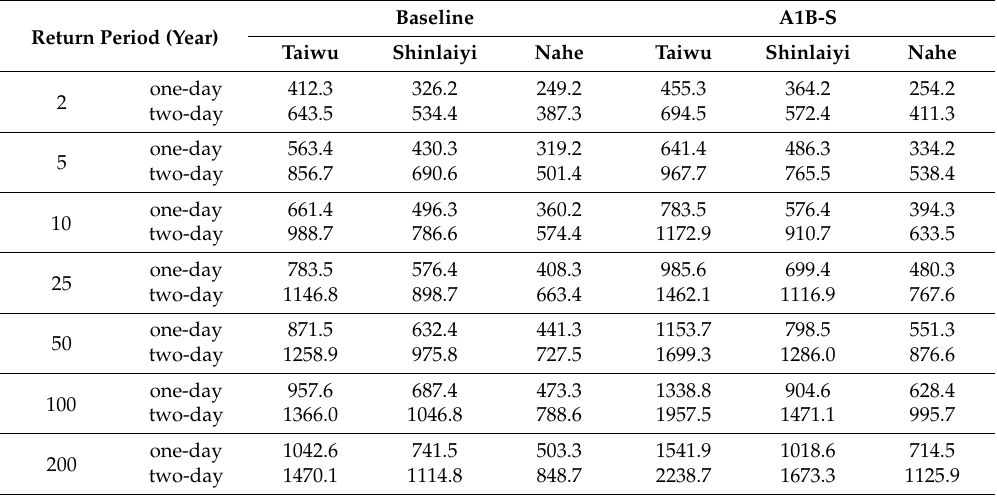
Table 4. Precipitation data of baseline and scenario A1B-S for one- and two-day storms under various return